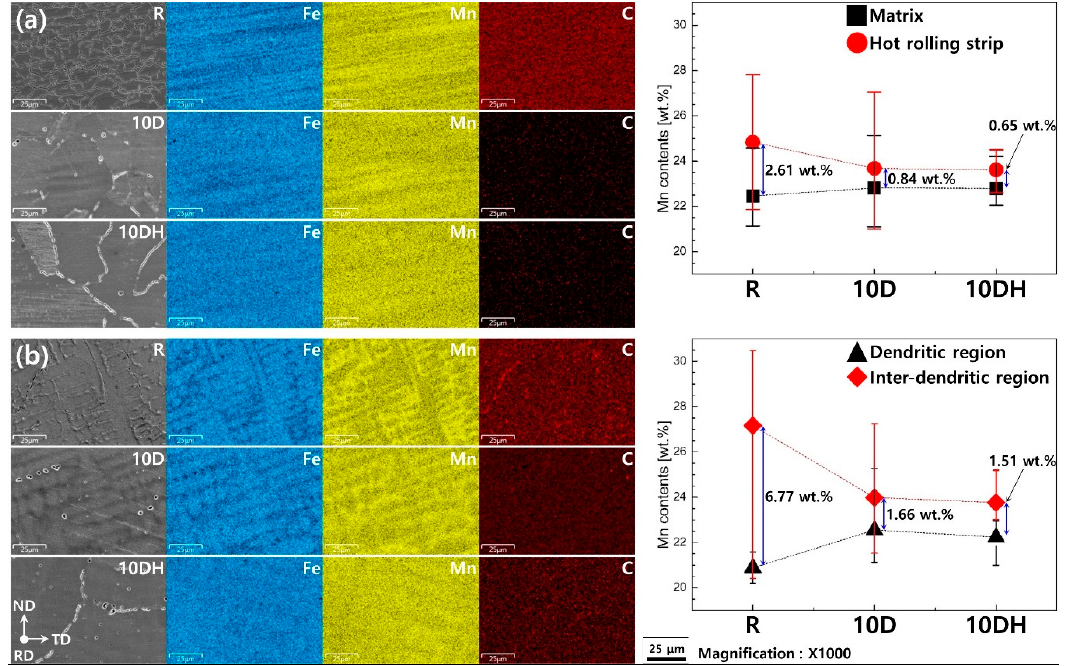
Figure 4. EDS results of image map and quantitative analysis for Mn in each region: ( a ) base metal and ( b ) weld metal.